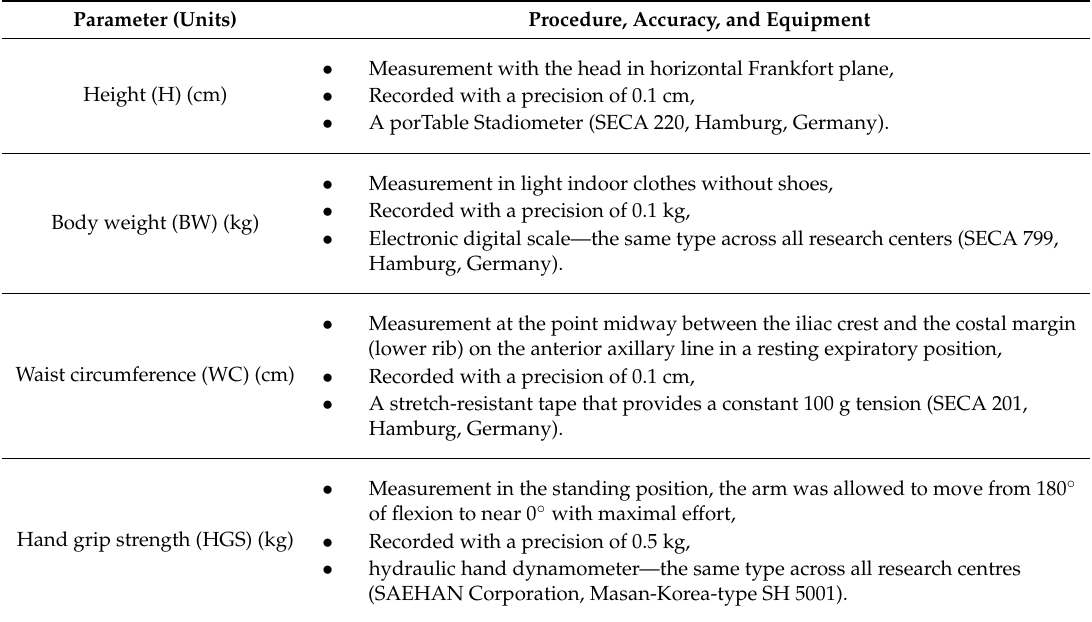
Table 6. Procedures for body composition